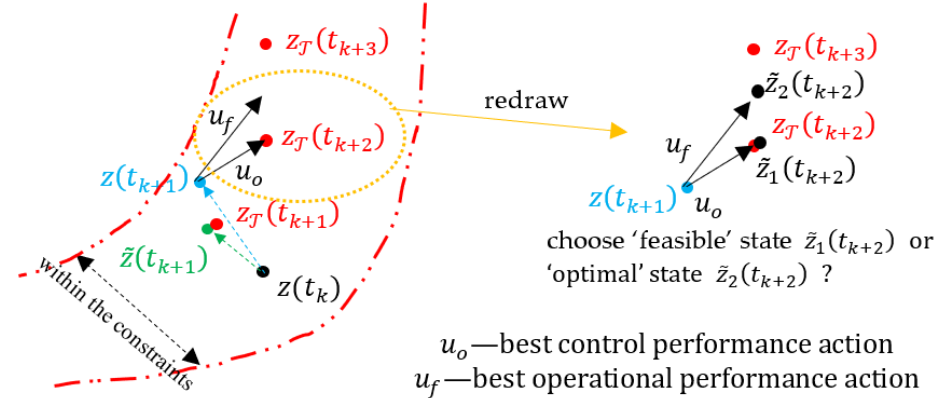
Figure 5. The impact of the beneficial disturbances.